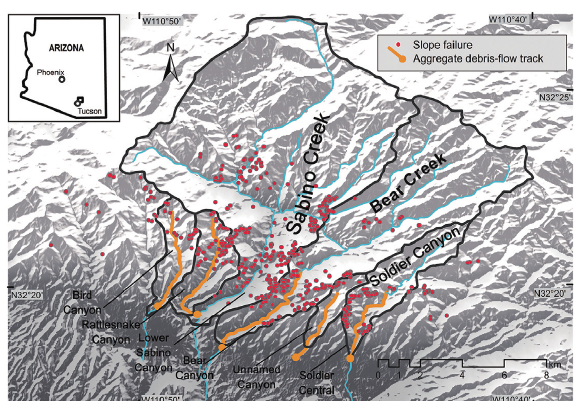
Figure 1: Location map showing the position of slope failures and debris flows that occurred in Santa Catalina Mountainous area, Pima County, southern Arizona, in late July 2006.